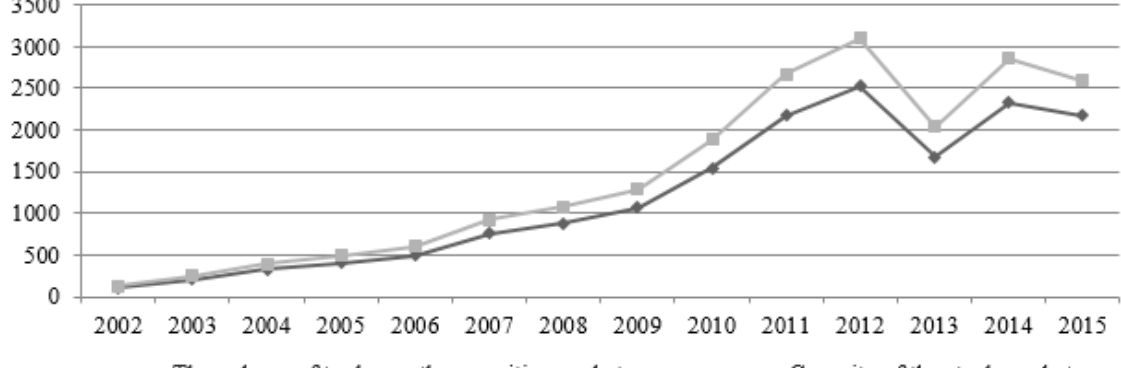
Fig. 2. The real values of the volume of trades on the Ukrainian securities market and the estimated values of its capacity for the period of 2005 – 2015